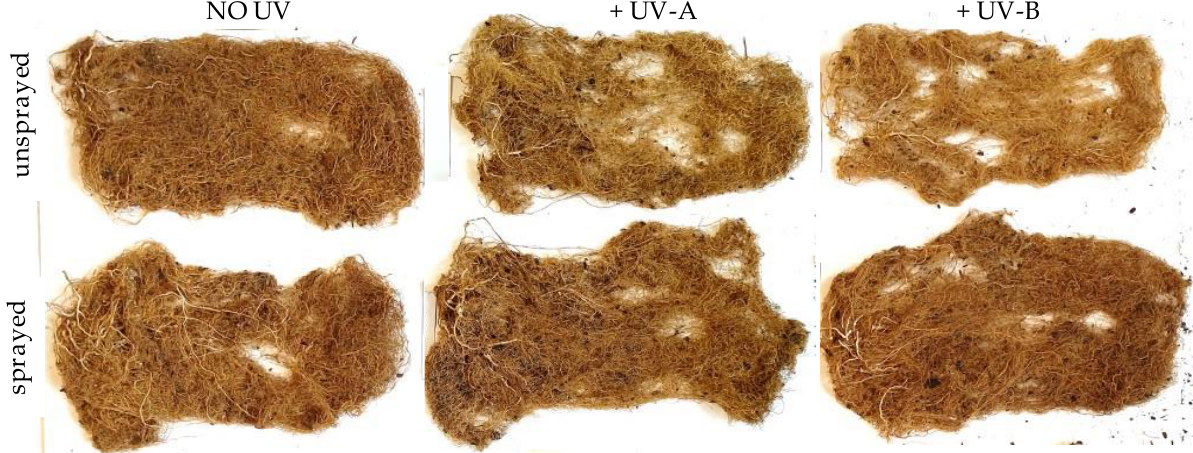
Figure 6. Images of roots washed and dried, under trial treatments.